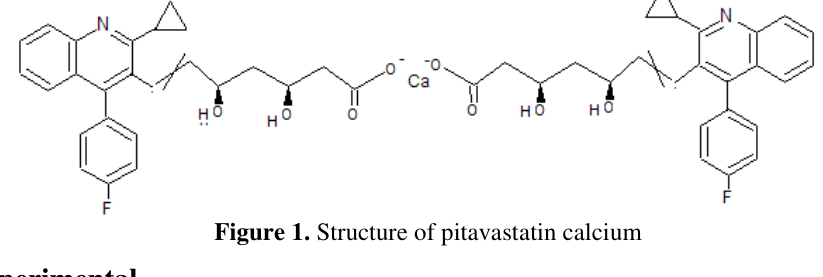
Figure 1. Structure of pitavastatin